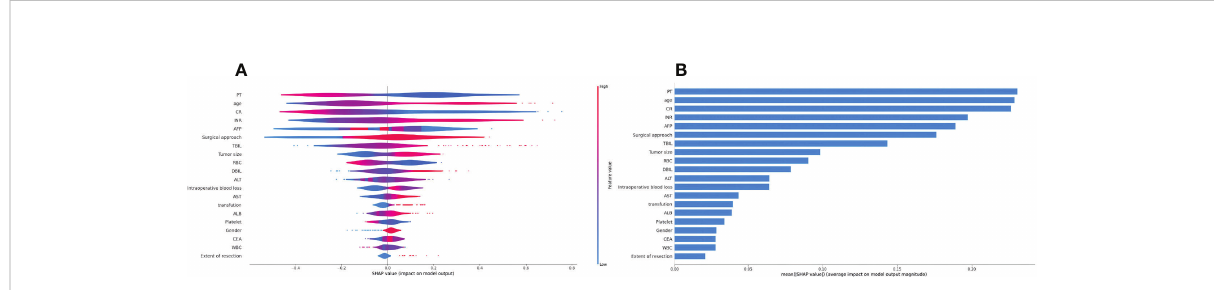
FIGURE 2 Summary Shapley additive explanations plot revealing the impact of individual clinical variables. (A) The importance matrix plot of clinical variables is derived using the LightGBM model. The matrix plot ranks the importance of the variables selected for the fi nal analysis, revealing the contribution of each variable to PHLF versus non-PHLF. (B) The SHAP summary plot of the LightGBM model is shown. The higher the SHAP value for each clinical variable, the higher risk of PHLF. LightGBM, light gradient boosting machines; PHLF, post-hepatectomy liver